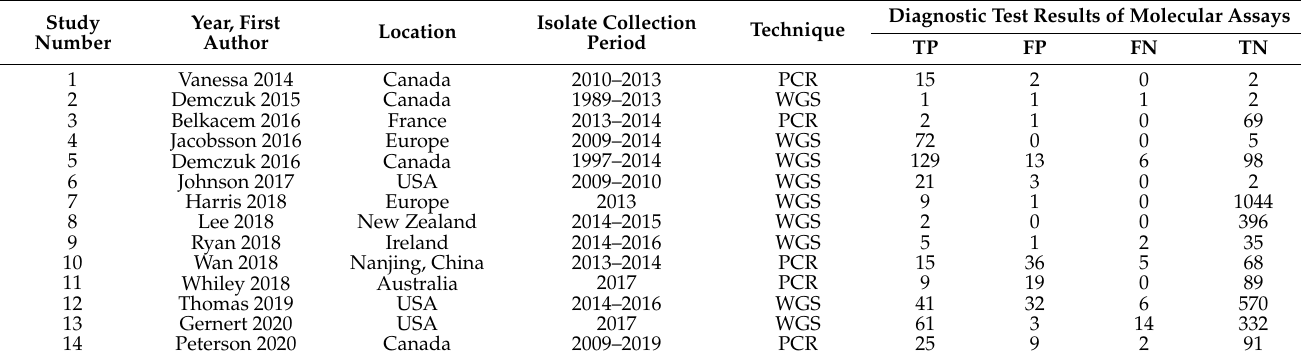
Table 3. The data and characteristics of 14 studies whose moderate-level drug resistance breakpoint was 4–128